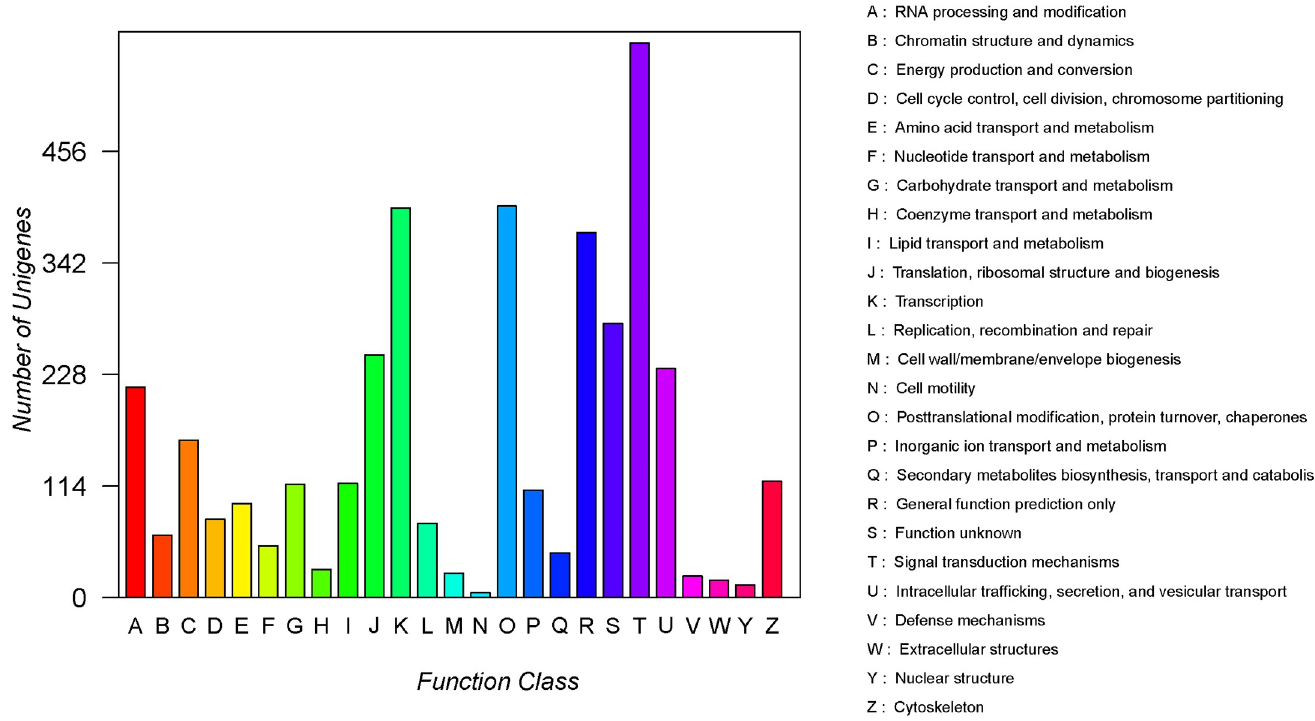
Fig 3. COG classification of S . insularis unigenes.